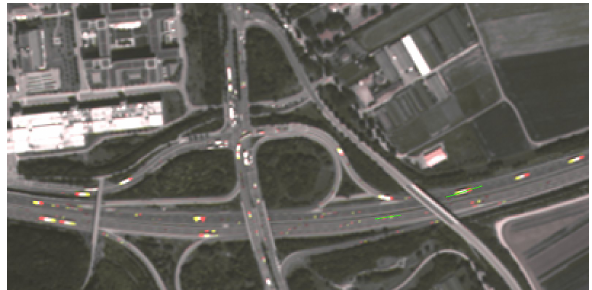
Figure 4: Displacement of cars seen by WorldView-2 in the red and yellow band (section 800 × 400 m on A99 north of Munich) In this image the displacement of moving cars in the two channels is clearly visible. Knowing the right-hand-traffic in Germany we